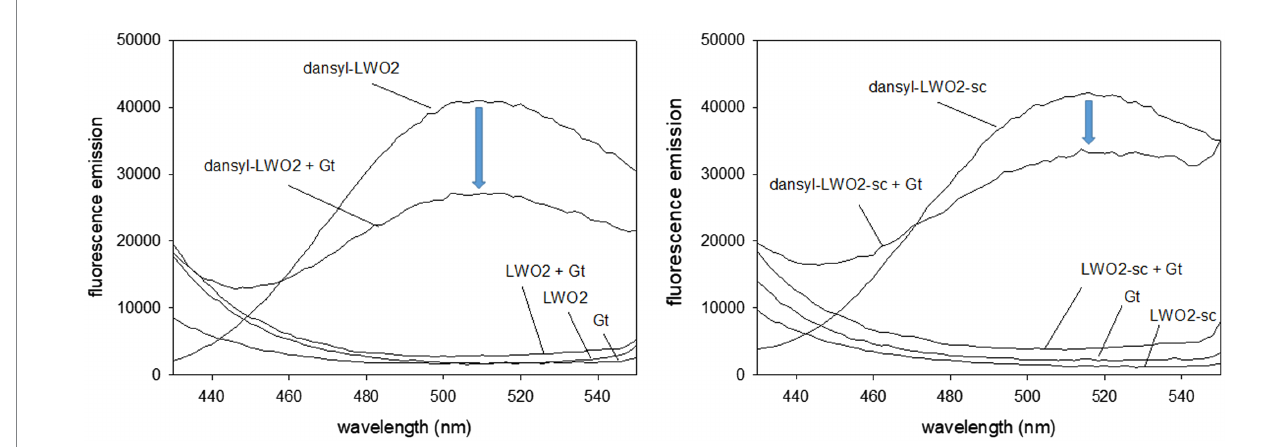
FIGURE 4 Fluorescence study with dansylated peptides dansyl-LWO2 and dansyl-LWO2-sc. Peptides and Gt α /Gi α were present at equal concentration of 16.7 μ M. Excitation was at 280 nm, the emission was recorded from 430 to 550 nm. Left panel: FRET measurements of dansyl-LWO2 in the absence and presence of Gt α /Gi α (indicated as Gt); right panel: FRET measurements of dansyl-LWO2-sc in the absence and presence of Gt α /Gi α . No emission was observed with label-free peptides in the absence and presence of Gt α /Gi α .